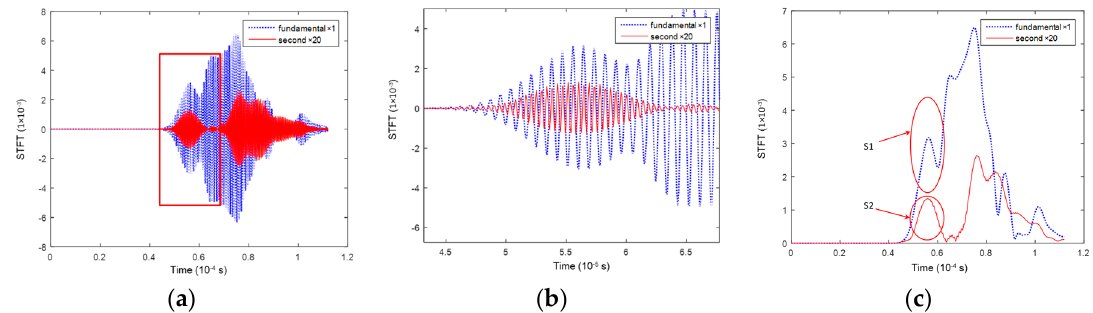
Figure 12. Signals of the mode pair S 1 -S 2 3.42 MHz mm–6.84 MHz mm at a propagation distance of 200 mm in the experiment (second harmonic mode × 20 times in amplitude). ( a ) Separated signals of the fundamental and second harmonic modes; ( b ) zoom-in signals of the S 1 and S 2 modes; and ( c ) separated energy packets of the S 1 and S 2 modes.